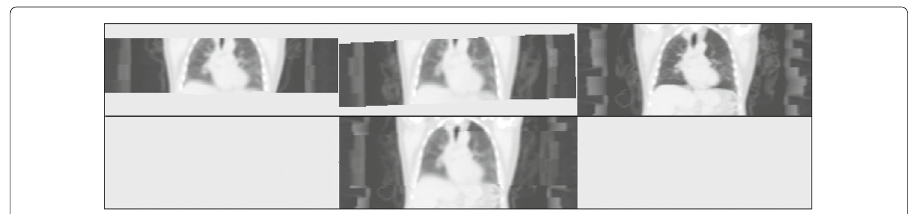
Fig. 5 Example patient original and combined-CT images. The registered original CT images from the early (top left), mid (top middle) and late (top right) study sections and the resulting combined-CT for the late section (bottom middle) for an example patient. Grey scale − 1350 < HU <